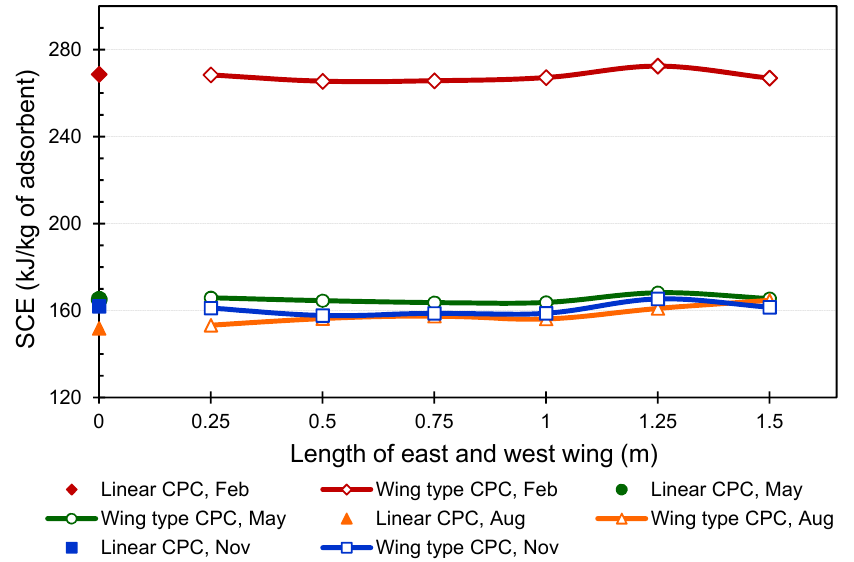
Figure 12. Summary of the effect of wings length and performance comparison for